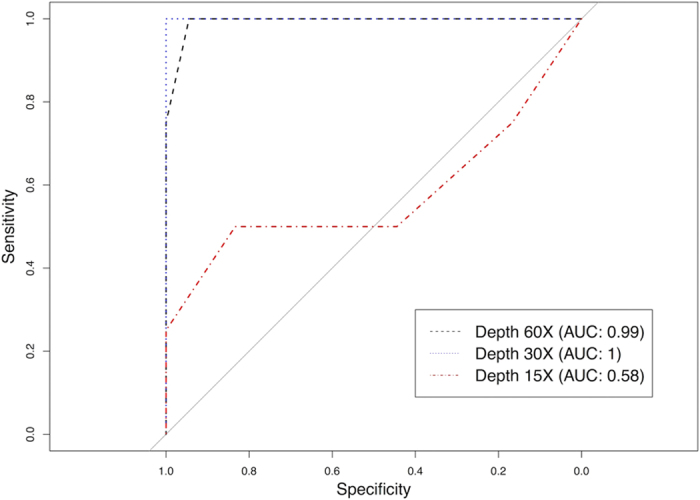
30× depth provides adequate somatic variant calls for NGSclassifier.Shown are MSI-status classification receiver operating characteristic (ROC) curves. S.ind was calculated from the mutations list generated by a GATK pipeline similar that used in reference 18. Full-depth or down-sampled exome BAM files from 22 tumor-normal pairs were analyzed. AUC, area under the curve.